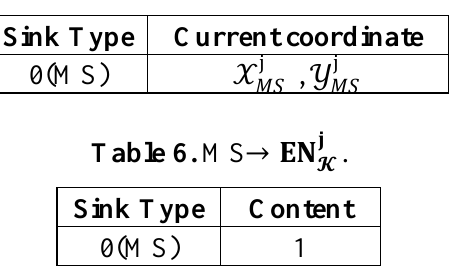
Table 5. Feedback (ACK) MS → SS.